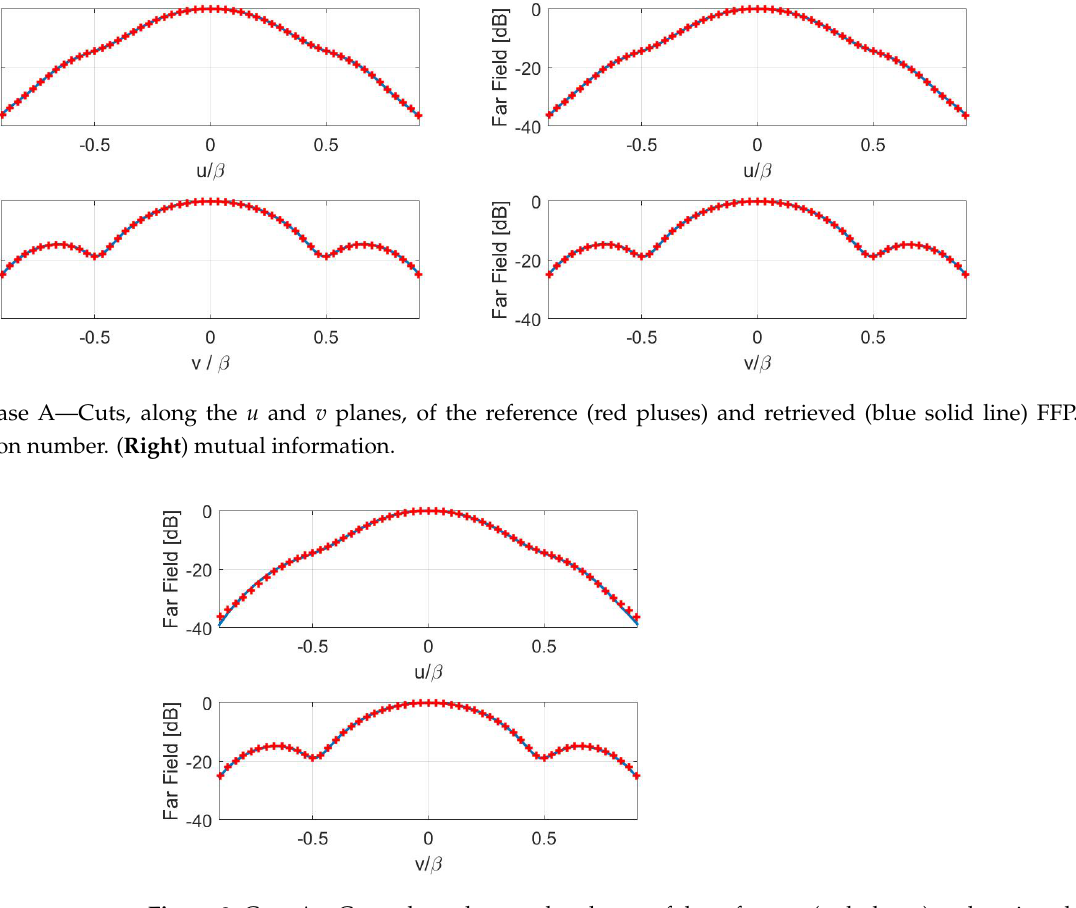
Figure 8. Case A—Cuts, along the u and v planes, of the reference (red pluses) and retrieved (blue solid line) FFP. Fisher